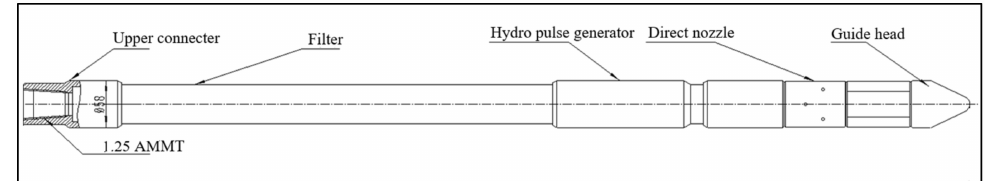
Figure 2. Schematic diagram of jet tool